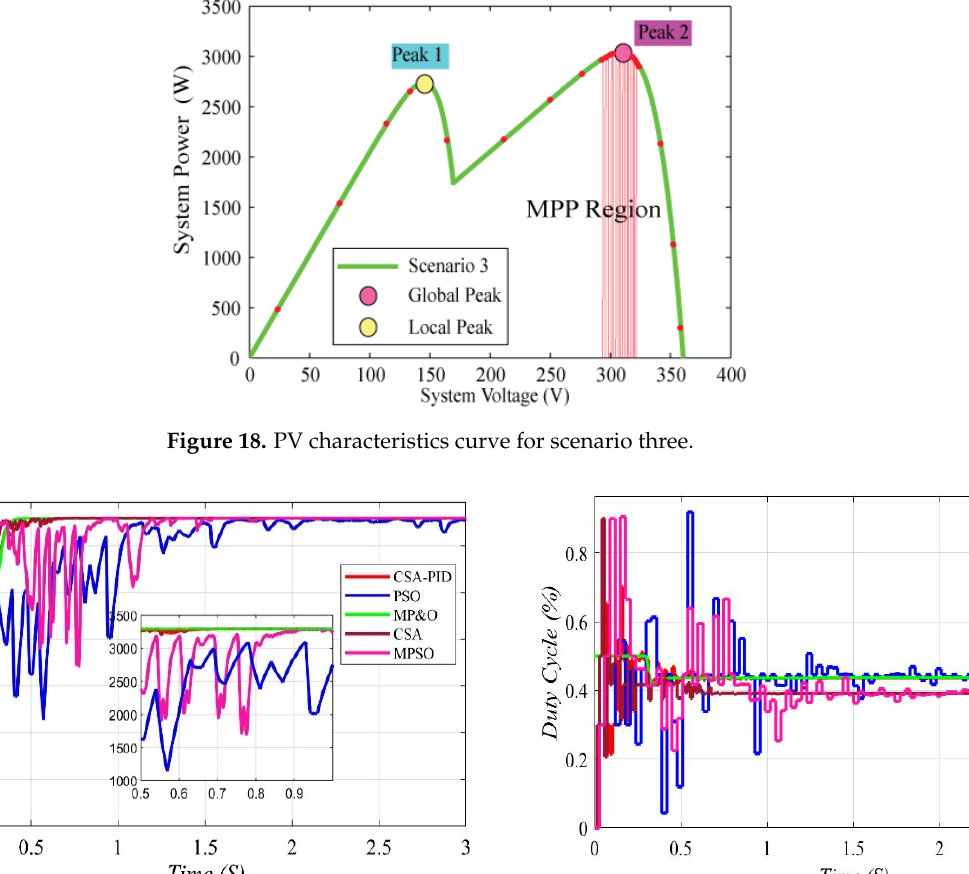
Figure 19. Details of duty cycle and power of proposed CSA-PID, CSA, MPSO, PSO, and MP&O controllers under scenario three. ( a ) The output power of proposed CSA-PID, CSA, MPSO, PSO, and MP&O. ( b ) The output duty cycle of proposed CSA-PID, CSA, MPSO, PSO, and MP&O.